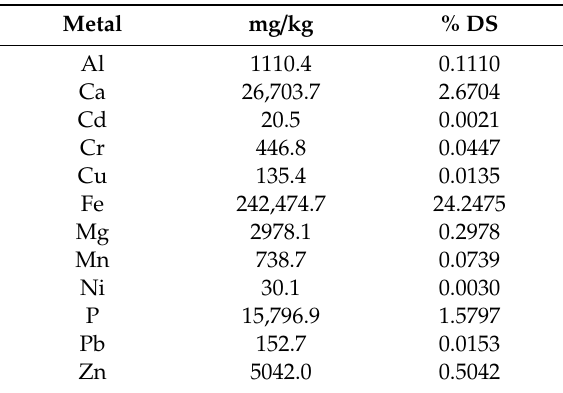
Table 2. The content of metals in the sludge collected for testing.